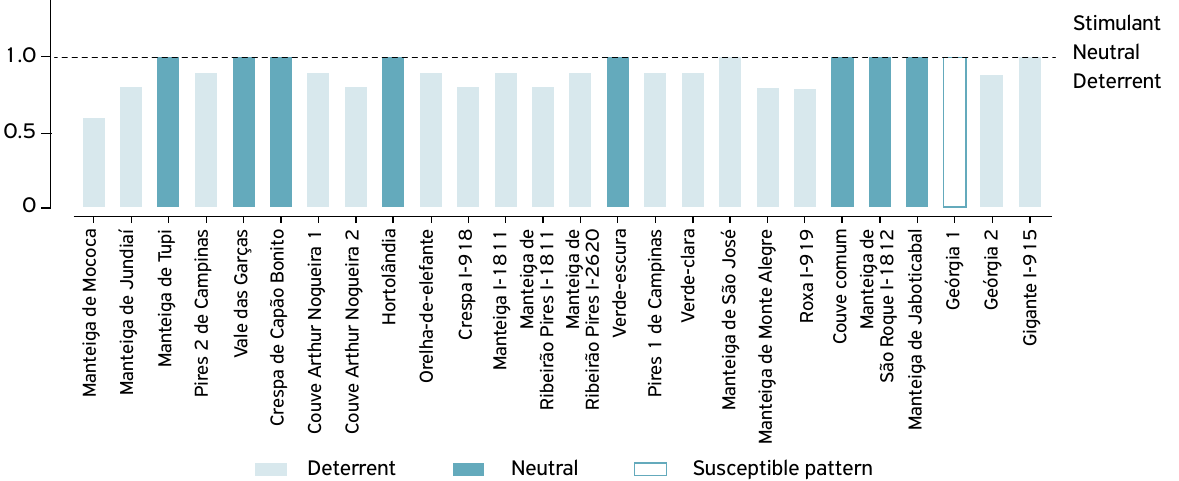
Stimulant Neutral